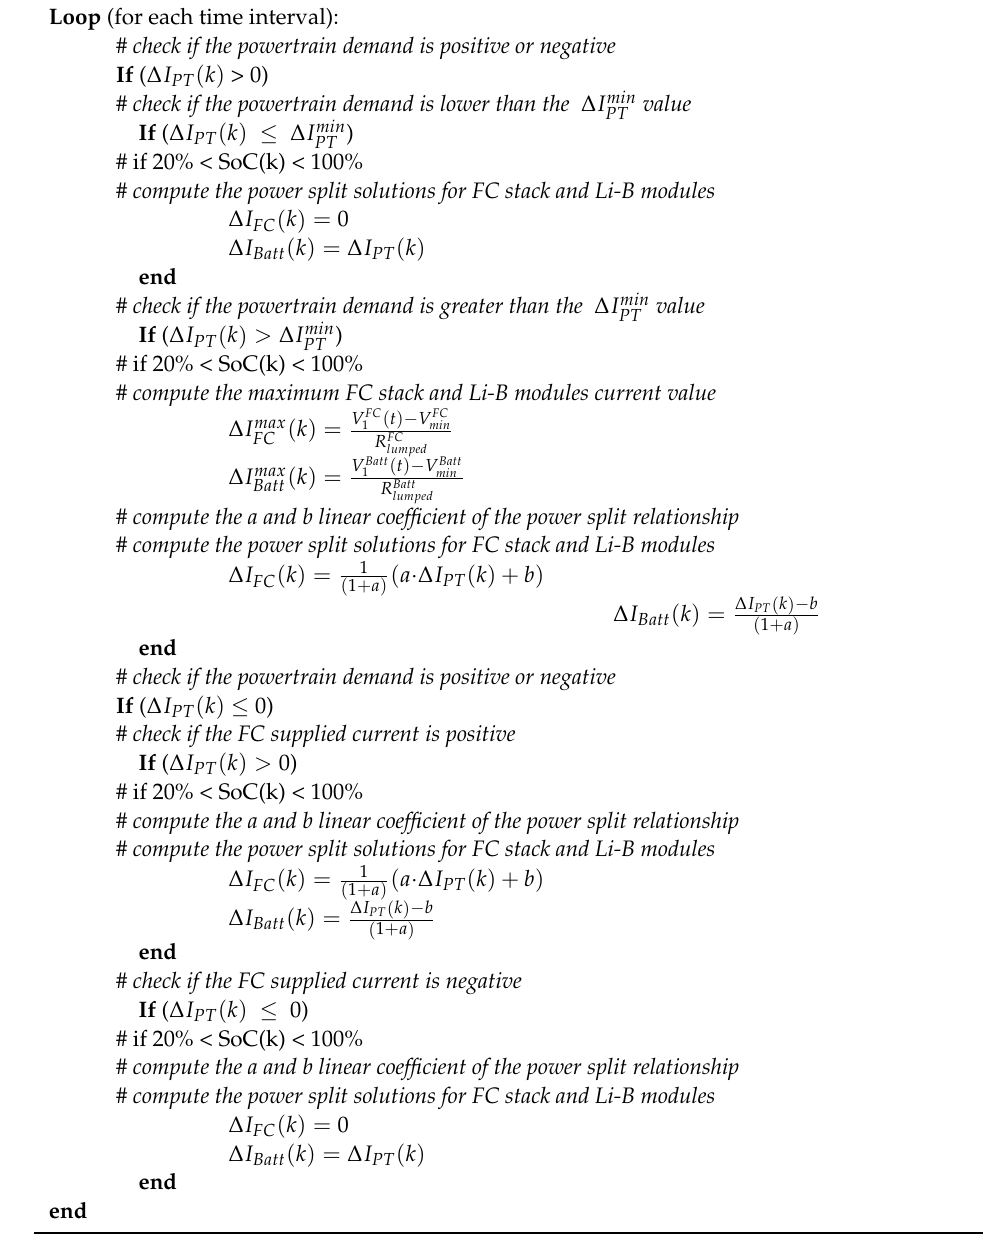
Algorithm 1 shows the pseudocode of the Power Split Algorithm for hybrid ESSs consisting of FC stack and Li-B module in order to clarify each step in detail. Algorithm 1: Power split algorithm for hybrid FC stack and Li-B module